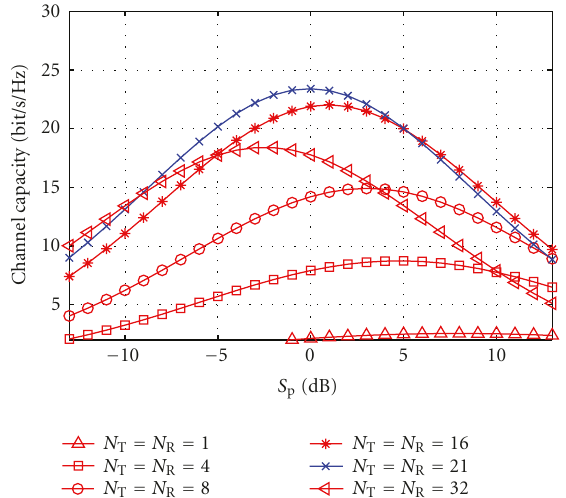
Figure 8: Capacity versus pilot boost for N × N MIMO-OFDM system for di ff erent number of antennas N , SNR γ 6, D t = 8, M f = 16, M t = 9.